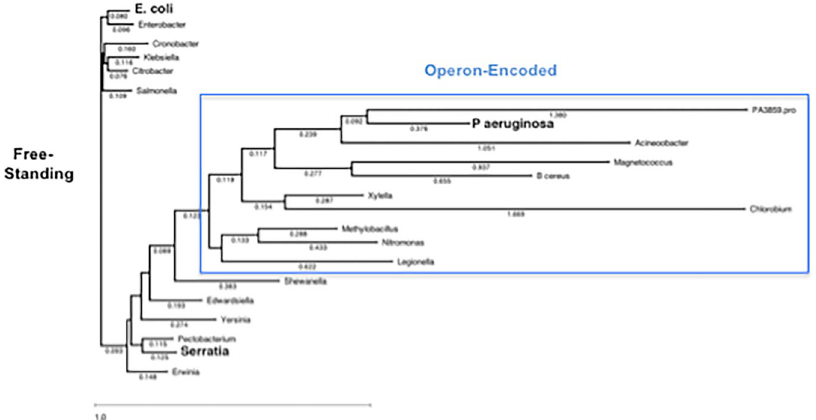
Figure 8. Phylogenetic tree of bacterial BioH proteins. The three BioH proteins with demonstrated pimeloyl- ACP methyl ester cleavage activity are given in large bold type. The PA3859 protein is included as the outlier since it is a P. aeruginosa α / β -hydrolase known to lack pimeloyl-ACP methyl ester cleavage activity 31 . The blue dotted box with the exception of PA3859 denotes the operon-encoded BioH proteins. The other BioH proteins (those outside the blue box) are defined as freestanding. The six bacterial species at the top left have very similar genomes with bioH immediately adjacent to the divergently transcribed gntX gene. The other freestanding bioH genes were identified using the adjacent divergently transcribed comFC gene. The additional criteria used in identification of all freestanding genes are described in the text. The numbers denote genetic distances which are estimates of the degree of divergence between two sequences and indicates the number of mutations (amino acid residue changes or insertion-deletions) that have occurred since the two sequences shared a common ancestor. The tree was calculated using Clustal Omega (http://clustal.org/omega/) and the Kimura metric 39, 40 . B. cereus denotes Bacillus cereus and closely related species because other bacilli (e.g., Bacillus subtilis ) synthesize biotin using a pathway that does not utilize BioH and